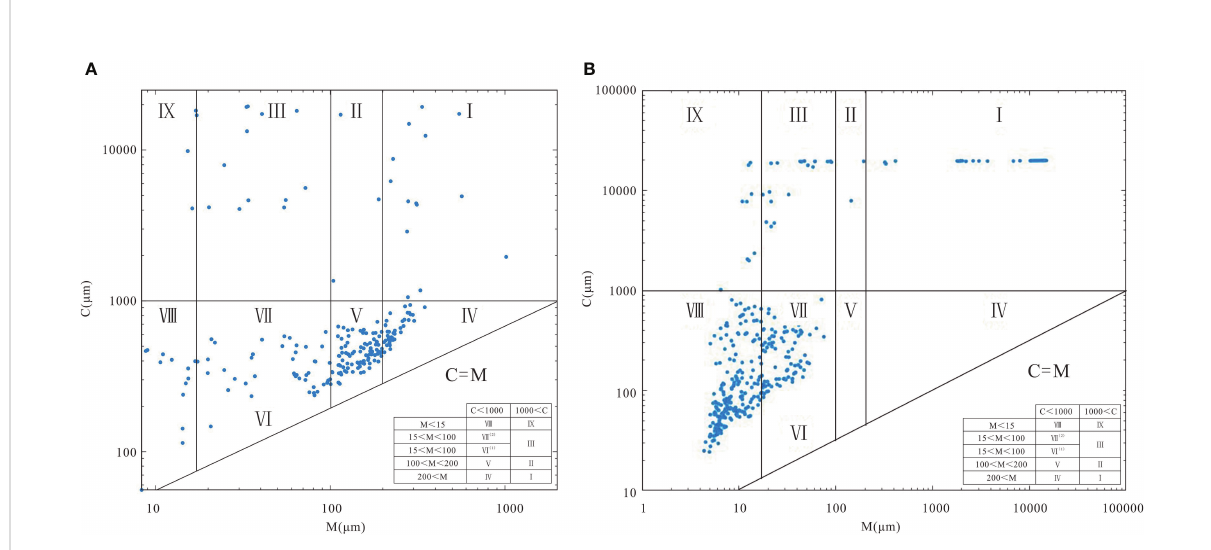
Standard deviation Variation coef fi cient